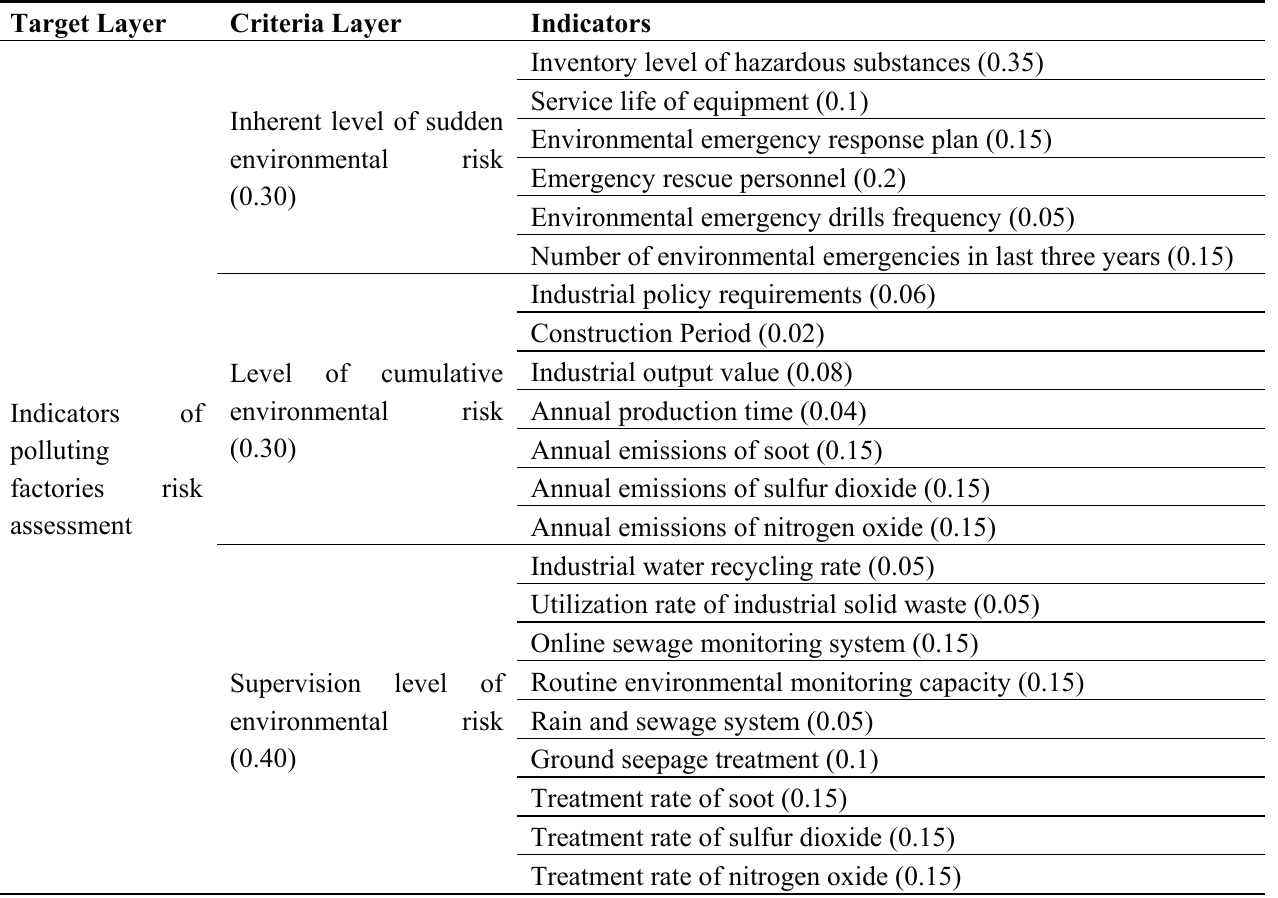
Table 1. Risk assessment indicators of polluting